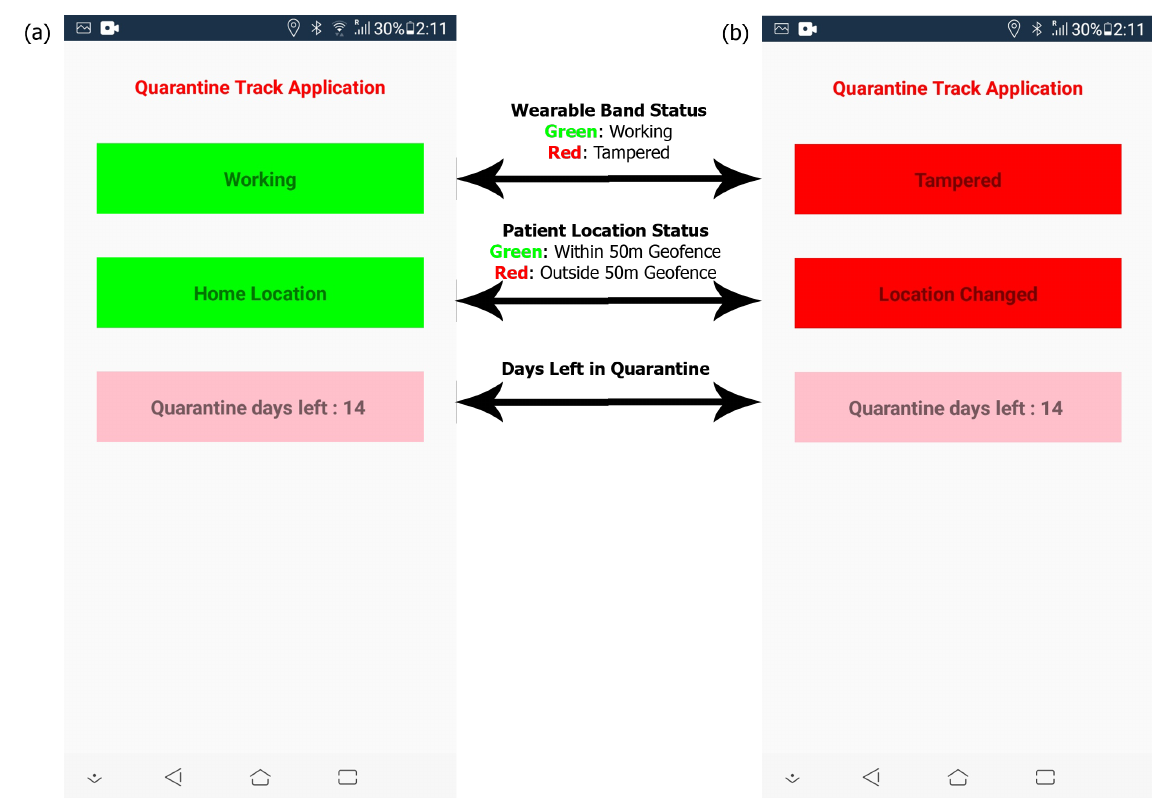
Figure 5. The IoT-Q-Band system’s mobile application screens showing the cases, (a) when the band is connected, and the subject is within 50 meters of registered quarantine Geo-location and (b) when the wearable tampered, and the patient is outside the 50 meters of the registered quarantine Geo-location. In each case, the user is shown the remaining quarantine